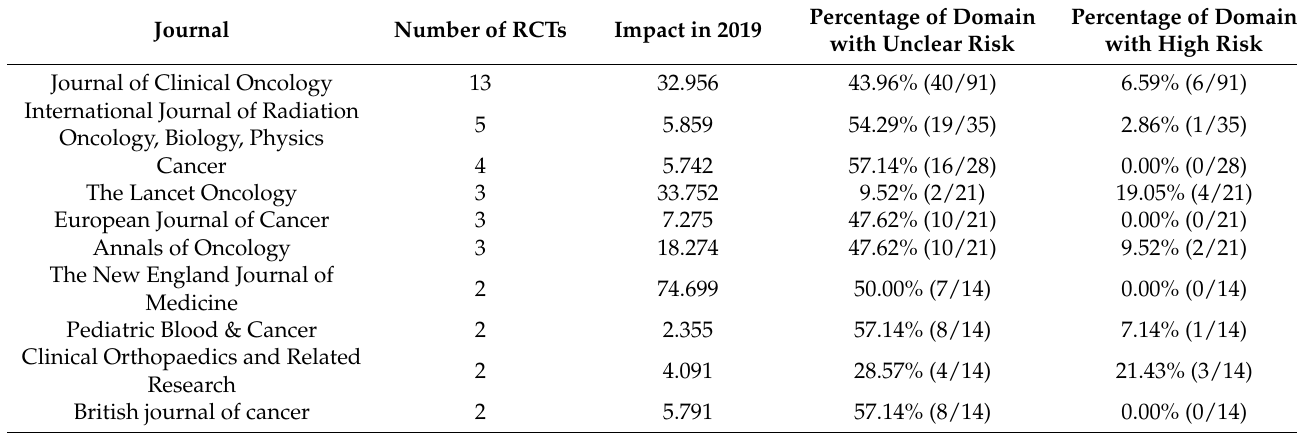
Figure 2. Comparison of risk of bias in medical and surgical RCTs regarding osteosarcoma and Ewing’s sarcoma ( A ). Distribution of medical and surgical RCTs. ( B ). Prevalence of risk of bias in medical RCTs. ( C ). Prevalence of risk of bias in surgical RCTs. Table 3. Most common journals for osteosarcoma and Ewing’s sarcoma RCTs, with 2019 impact factors and percentage of unclear and high-risk